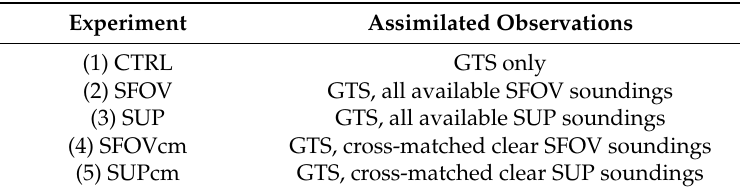
Table 1. The summary of numerical experiments in this study. The designed experiments are abbreviated in the left column, and assimilated observations are listed in the right column. Note that nine (3 by 3) clear SFOV soundings within one SUP footprint are considered as “cross-matched” in both SFOVcm and SUPcm experiments.